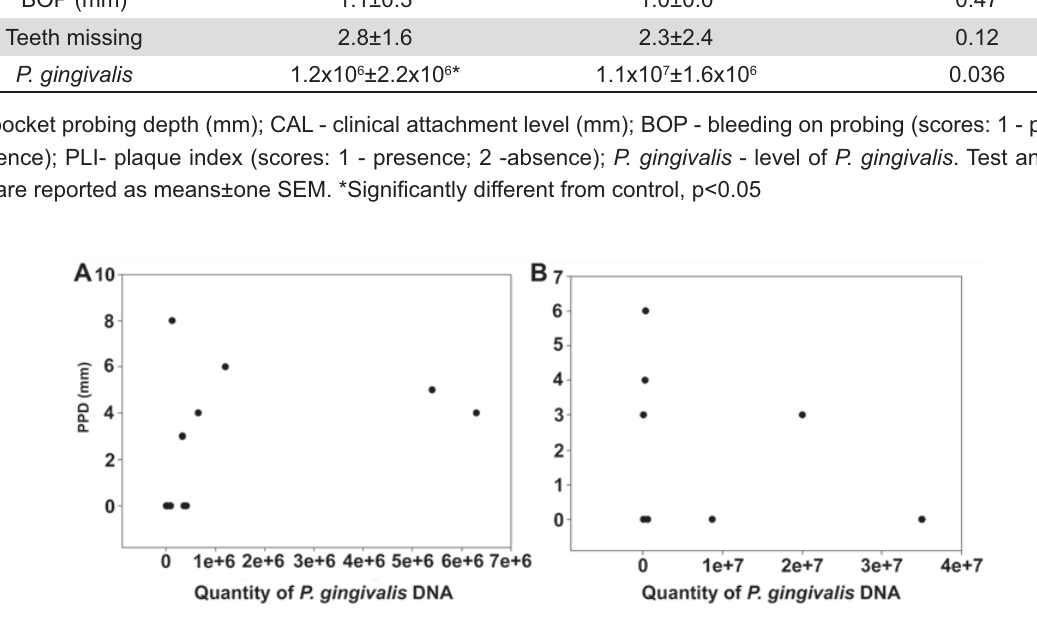
Figure 5- Correlation between the quantity of P. gingivalis DNA detected in subgingival plaque samples and pocket